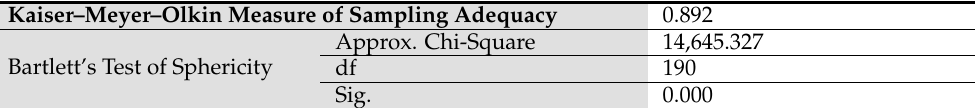
Table 3. KMO and Bartlett’s test for worker